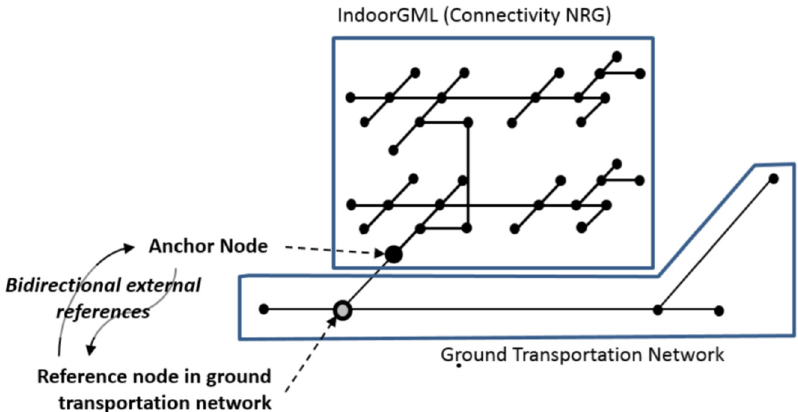
Figure 8. Anchor node connecting indoor and outdoor networks (Figure 16 of IndoorGML version1.0 document).